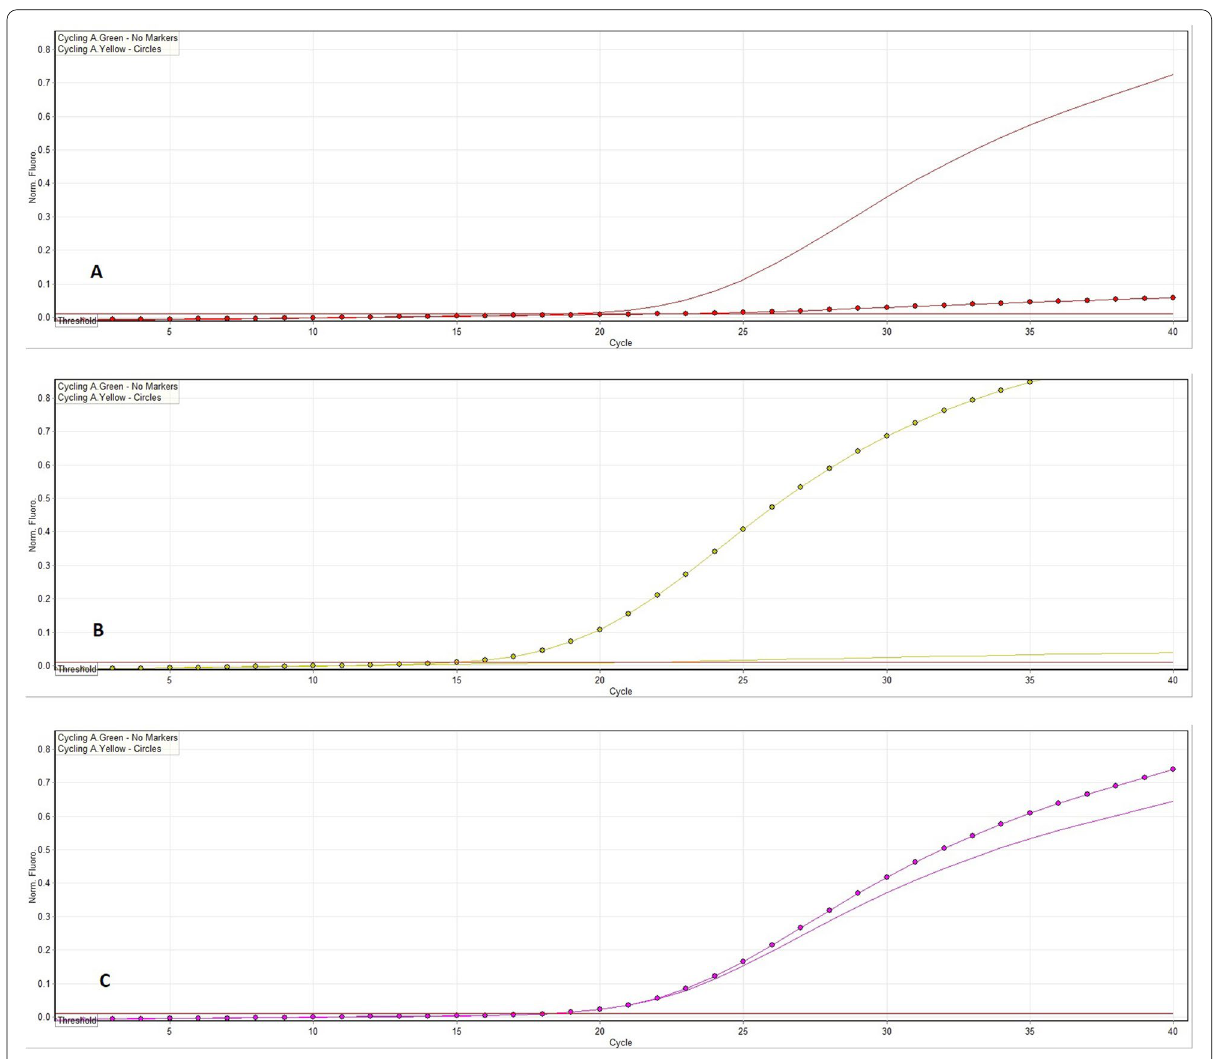
Fig. 1 Allelic discrimination curves produced by Rotor Gene real-time PCR system. The x -axis represents the amplification cycle number and the y -axis represents the fluorescent value. ( A ) Example of homozygote alleles labeled with FAM ™ . ( B ) Example of homozygote alleles labeled with VIC ™ . ( C ) Example of heterozygote alleles (one labeled with FAM ™ and the other labeled with VIC ™ )